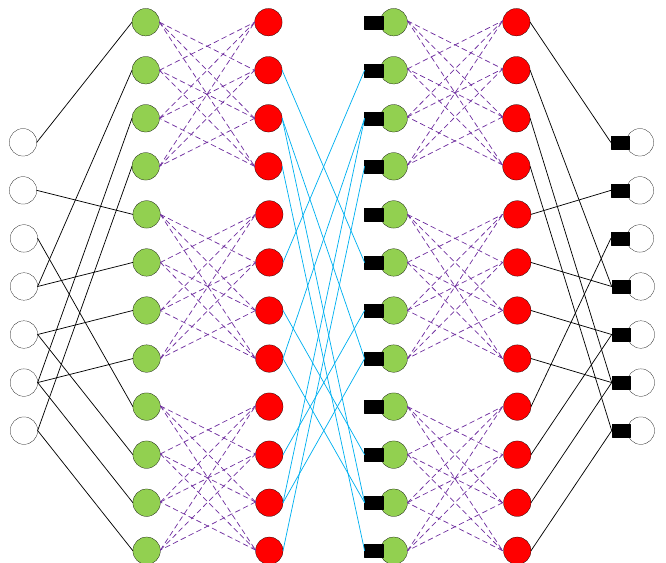
Figure 3. The neural network structure of 2 BP/min-sum iterations for the (7,4) QR code according to Equations (8) and (9). Green circles represent odd-layer neurons and red circles even-layer neurons. Circles with black rectangles are neurons with LLR values as input. The purple dashed lines represent w o 2 e weights and blue solid lines represent w e 2 o